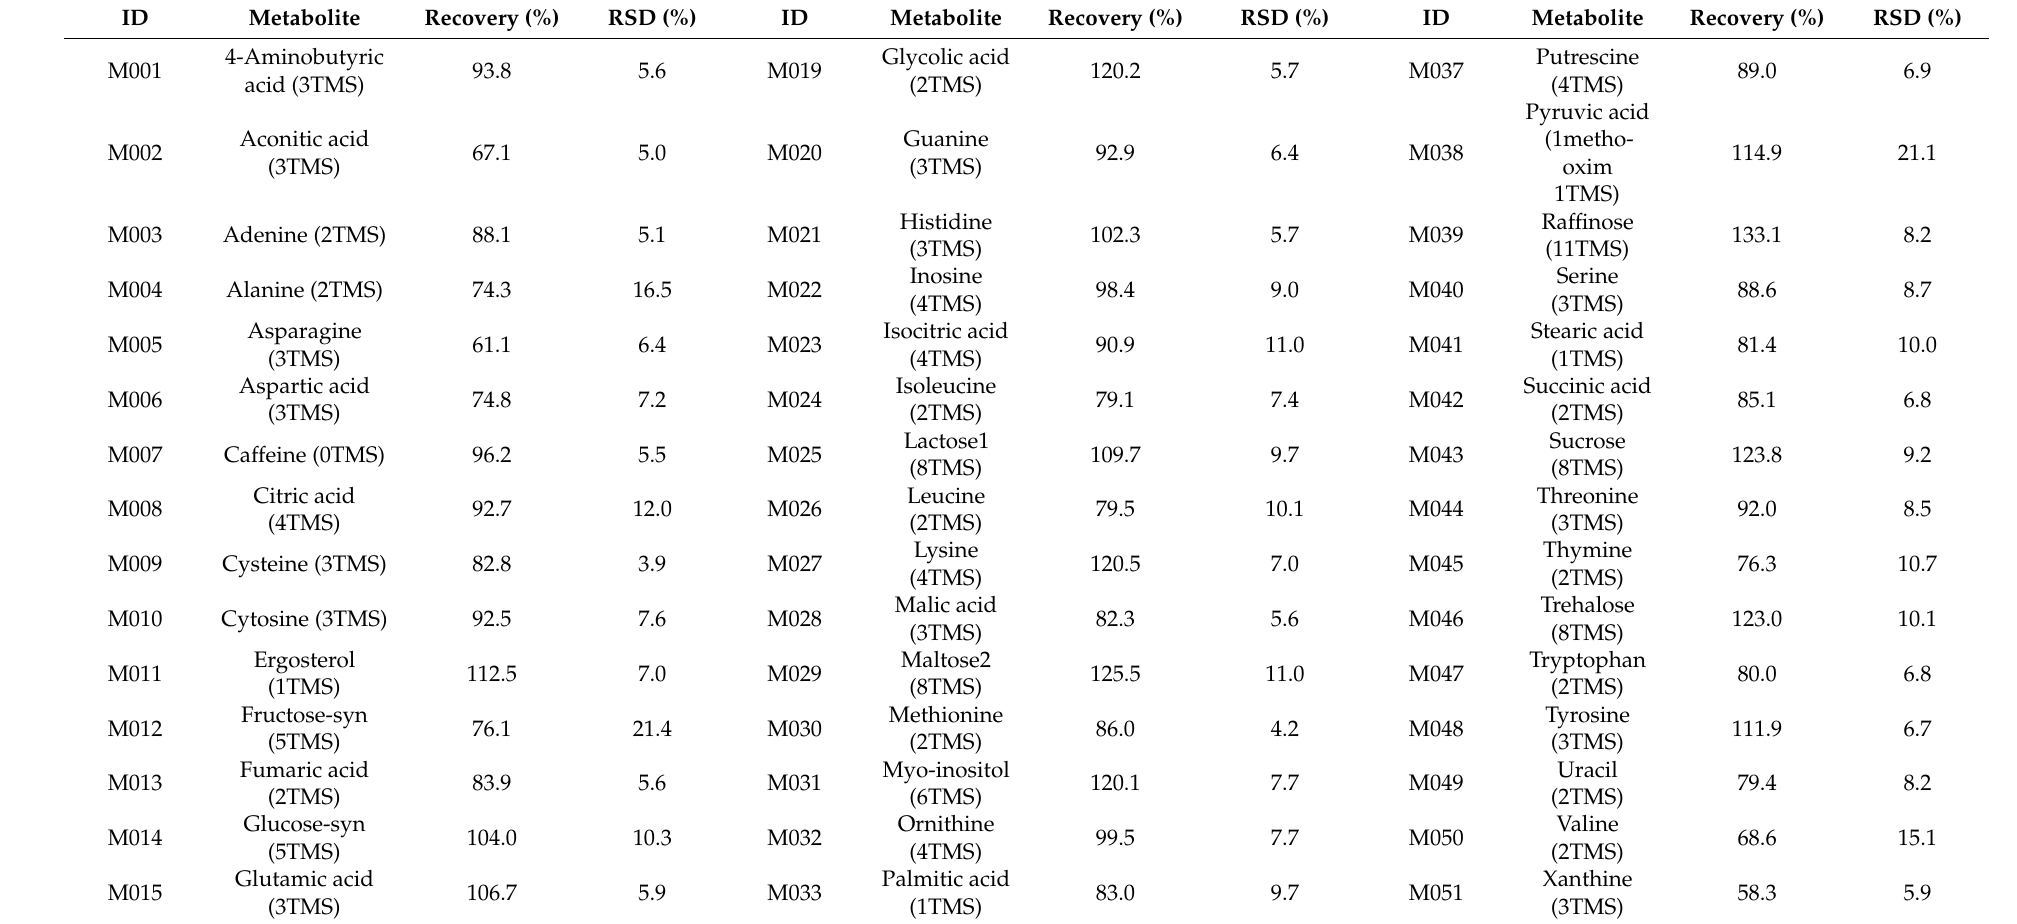
Table 2. Result of the addition-recovery